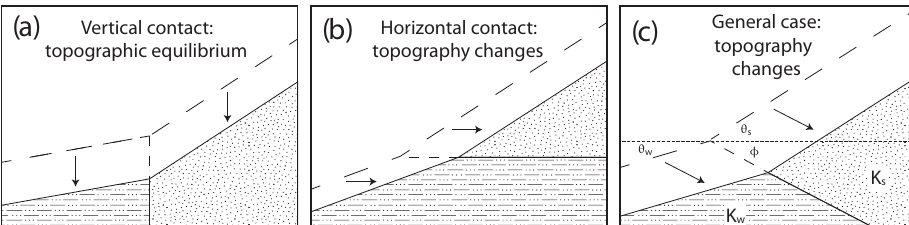
Figure 1. Topographic equilibrium in layered rocks. (a) Response of steepness to rock erodibility is typically derived from a perspective of topographic equilibrium, with equal vertical incision rates in all locations that are balanced by uplift. Topographic equilibrium does not occur in the case of non-vertical contacts. (b) For horizontal strata, horizontal retreat rates, rather than vertical incision, must be equal at the contact. (c) In general, retreat in the direction parallel to the contact must be equal within both rocks to maintain channel continuity. Dashed lines depict former land surface and contact positions, and arrows show the direction of equal erosion at the contact. Uplift is not